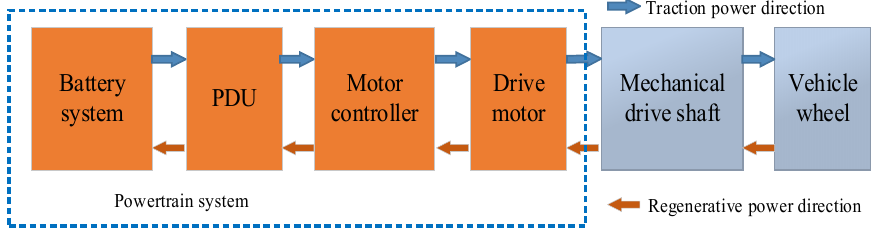
Figure 1. Schematic diagram of energy and power transmission process of BEVs.